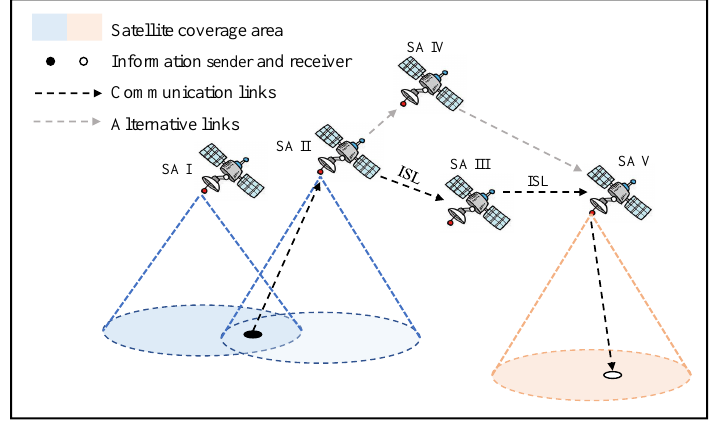
Figure 1. Simplified schematic diagram of Low-Earth Orbit (LEO) satellite network.